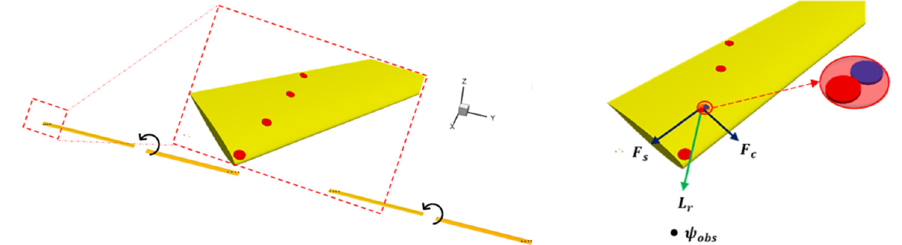
Figure 12. Sketch showing the directivity of the forces and the loads in relation to the observer as well as the dual piezo speaker configuration [55].